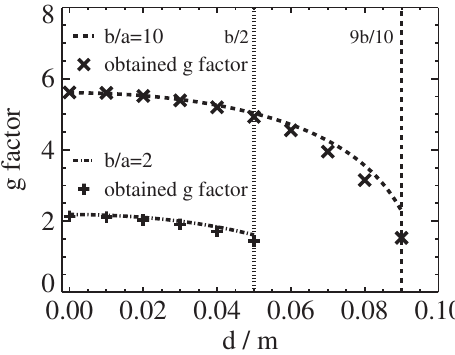
FIG. 13. Field configuration and integration path for the cal- culation of the longitudinal electric field for a uniform, round beam with a transverse offset d and a radius a in a circular vacuum chamber with radius b .